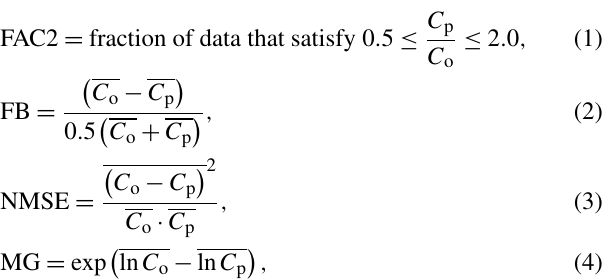
FAC2 = fraction of data that satisfy 0 . 5 ≤